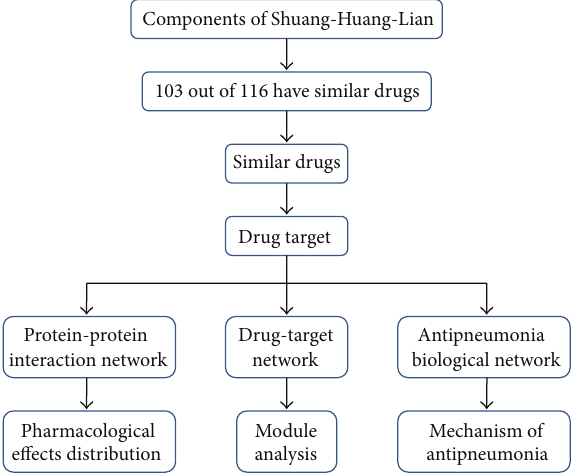
Figure 1: The workflow of SHL network construction and